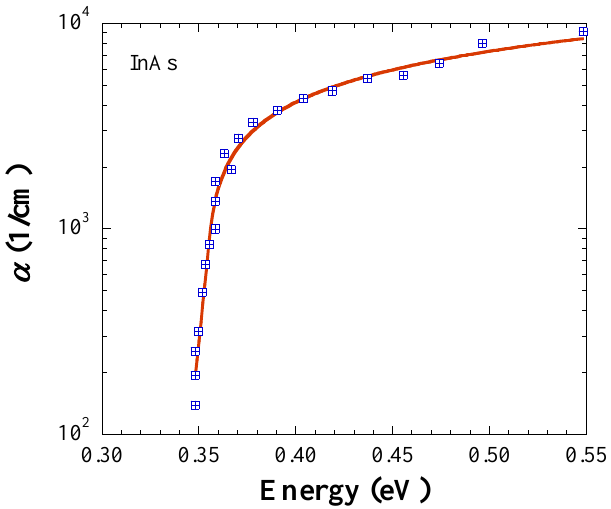
Figure 3. Absorption coefficient of InSb. The symbols are retrieved from Ref. [9], and the solid line represents the fit with Equations (5) and (6).